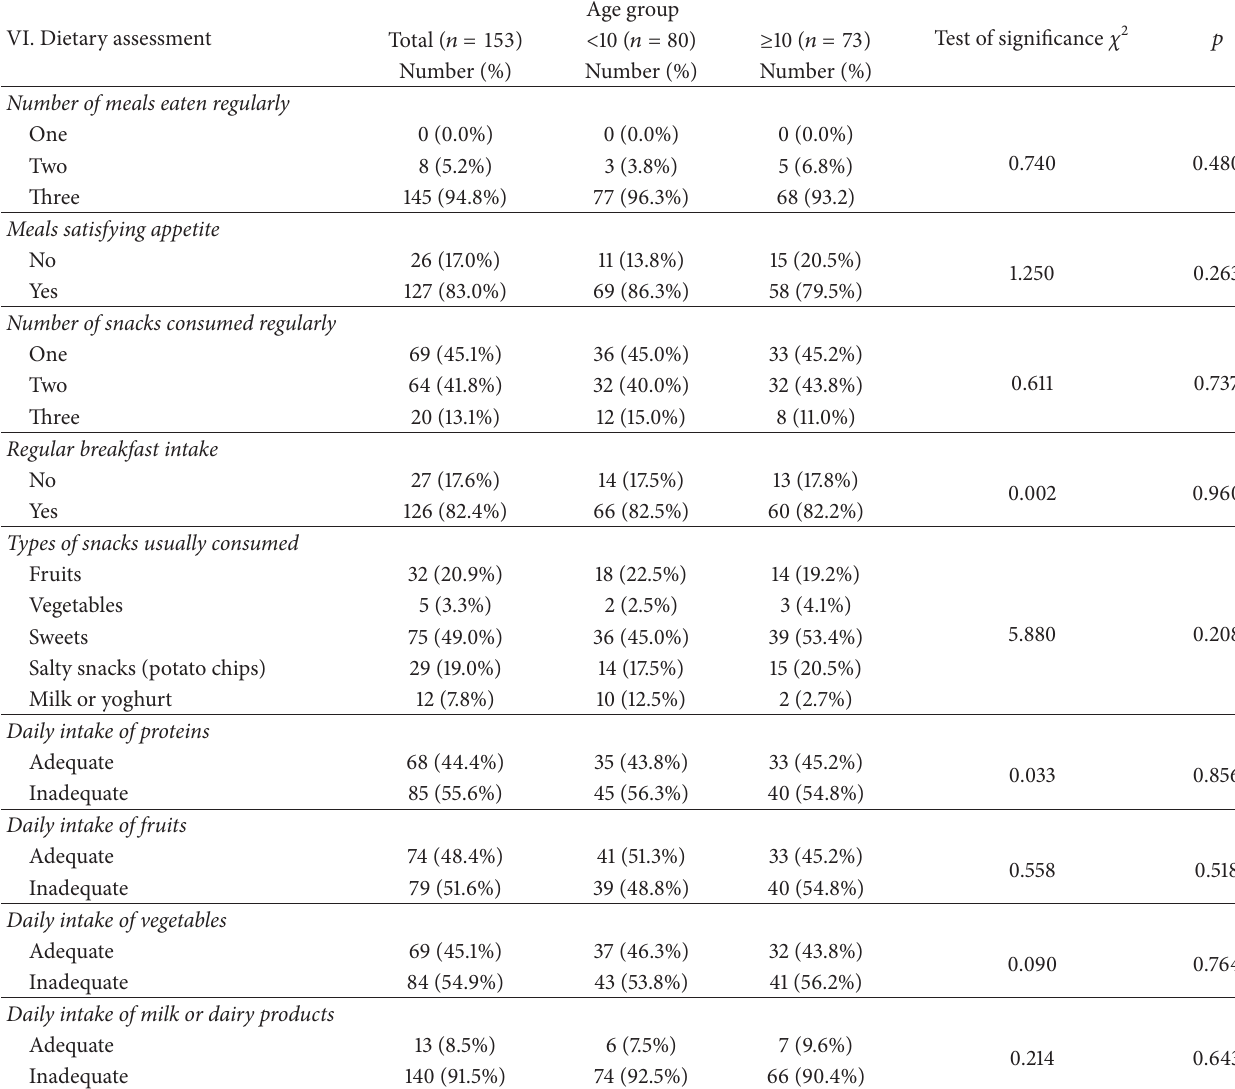
Table 3: Dietary